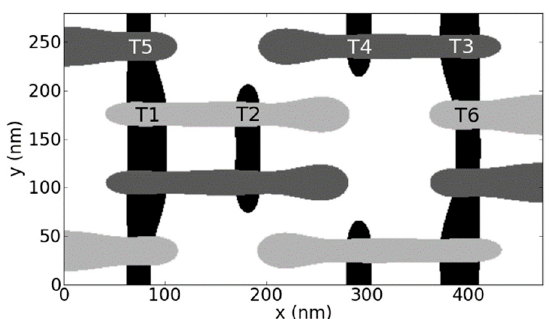
Figure 6. Top-view of lithography simulation of an SRAM cell. Black vertical features are the active silicon areas, the horizontal light grey and dark grey features are the polysilicon gate areas generated with the first and the second incremental lithography step, respectively. Transistors T1 to T6 are explained in the text.